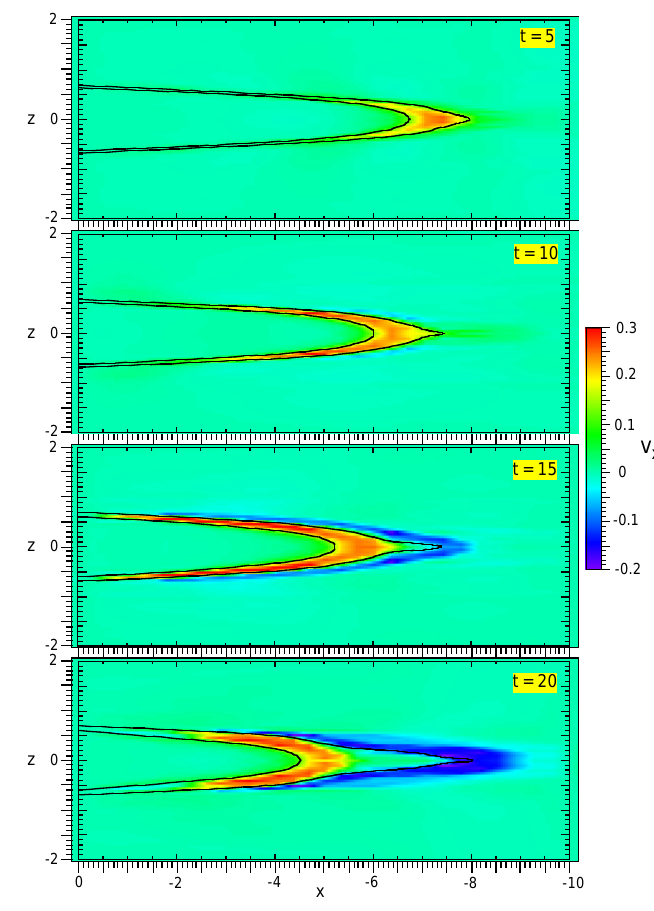
Fig. 5. Plasma velocity in the plane y = 0 for y m = 0 . 2 at different times as indicated. The solid lines are magnetic field lines bounding the depleted flux